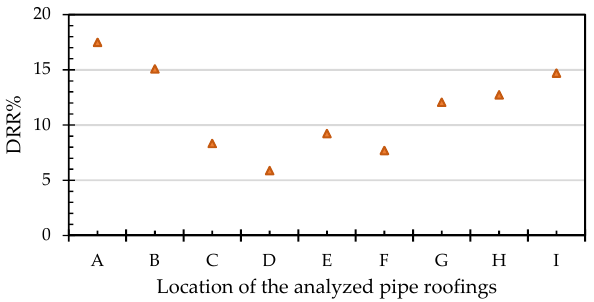
Figure 26. Comparison of the total displacements of the tunnels with and without pipe roofings.